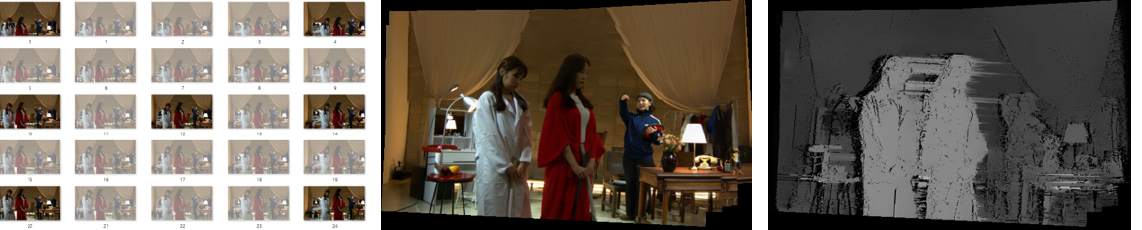
Figure 17. View synthesis with seven images is extended in the vertical and horizontal direction.